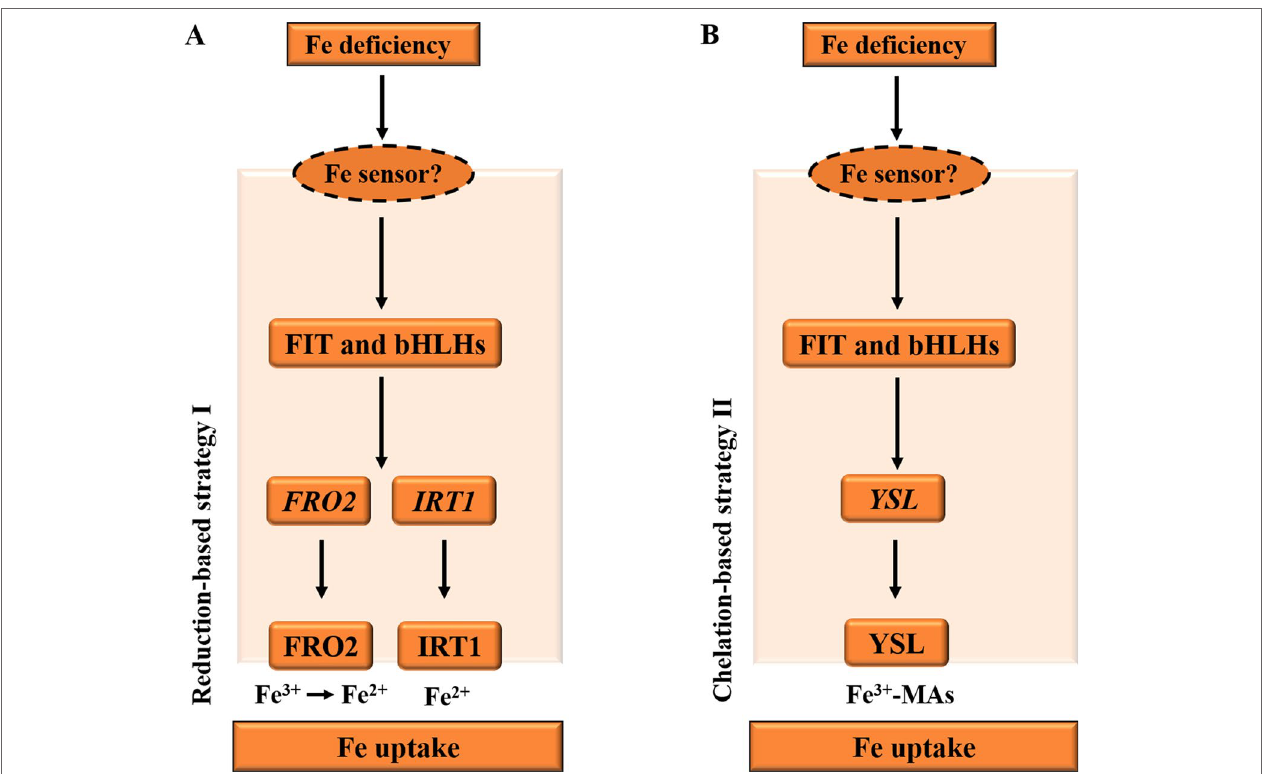
FIGURE 1 | Diagrams illustrating the iron deficiency response in Arabidopsis and Graminacea plants. (A) Under Fe deficiency, in Arabidopsis roots, the FIT and bHLH transcription factors, such as bHLH38 and bHLH39 in Arabidopsis , are activated by an unknown PM iron sensor in order to bind to the promoters of the iron-responsive genes. Subsequently, the induction of FRO2 and IRT1 activity is co-regulated in response to iron deficiency through the reduction-based strategy I for iron uptake. Iron is firstly reduced from ferric (Fe 3+ ) to ferrous (Fe 2+ ) iron by the reductase FRO2. Fe 2+ is then imported into the root cell by the metal transporter IRT1. (B) Under Fe deficiency, the FIT and bHLH transcription factors are activated to induce the strategy II Fe uptake system in Graminacea plant roots. Fe 3+ –MAs are transported into the root cell by the YSL. PM, plasma membrane; YSL, yellow stripe like; IRT1, iron-regulated transporter 1. The arrows refer to the positive interactions, while the question marks indicate the unknown iron